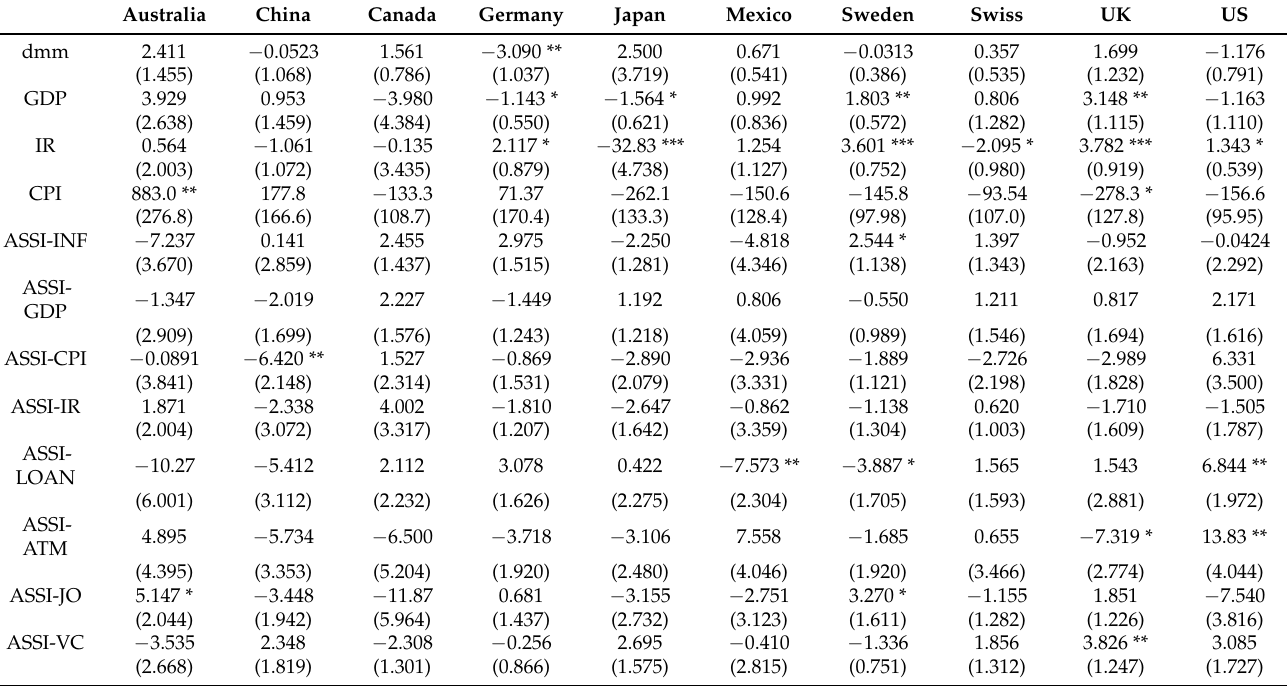
Table A21. Panel Regression OM Model with ASSI for